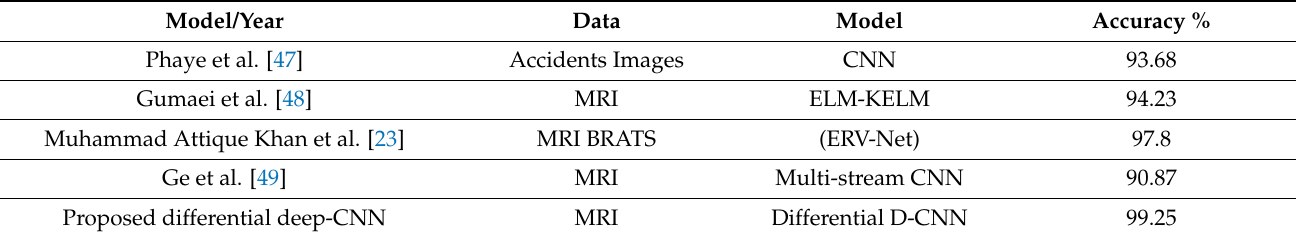
Table 3. Comparative differential D-CNN model with CNN-based methods using